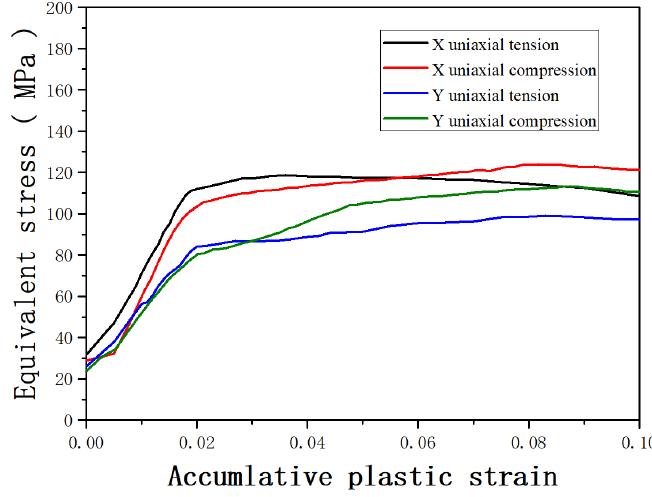
Figure 4. The experimental compression and tension stress-strain curves.